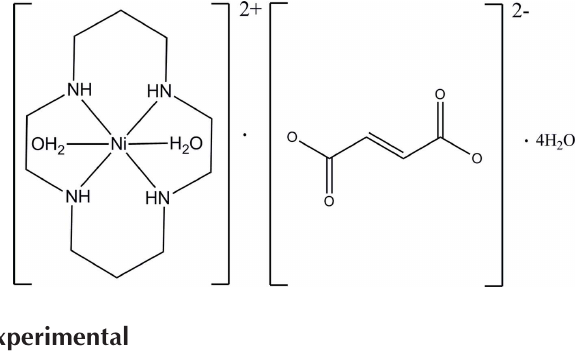
Data collection Bruker APEXII DUO CCD area- detector diffractometer